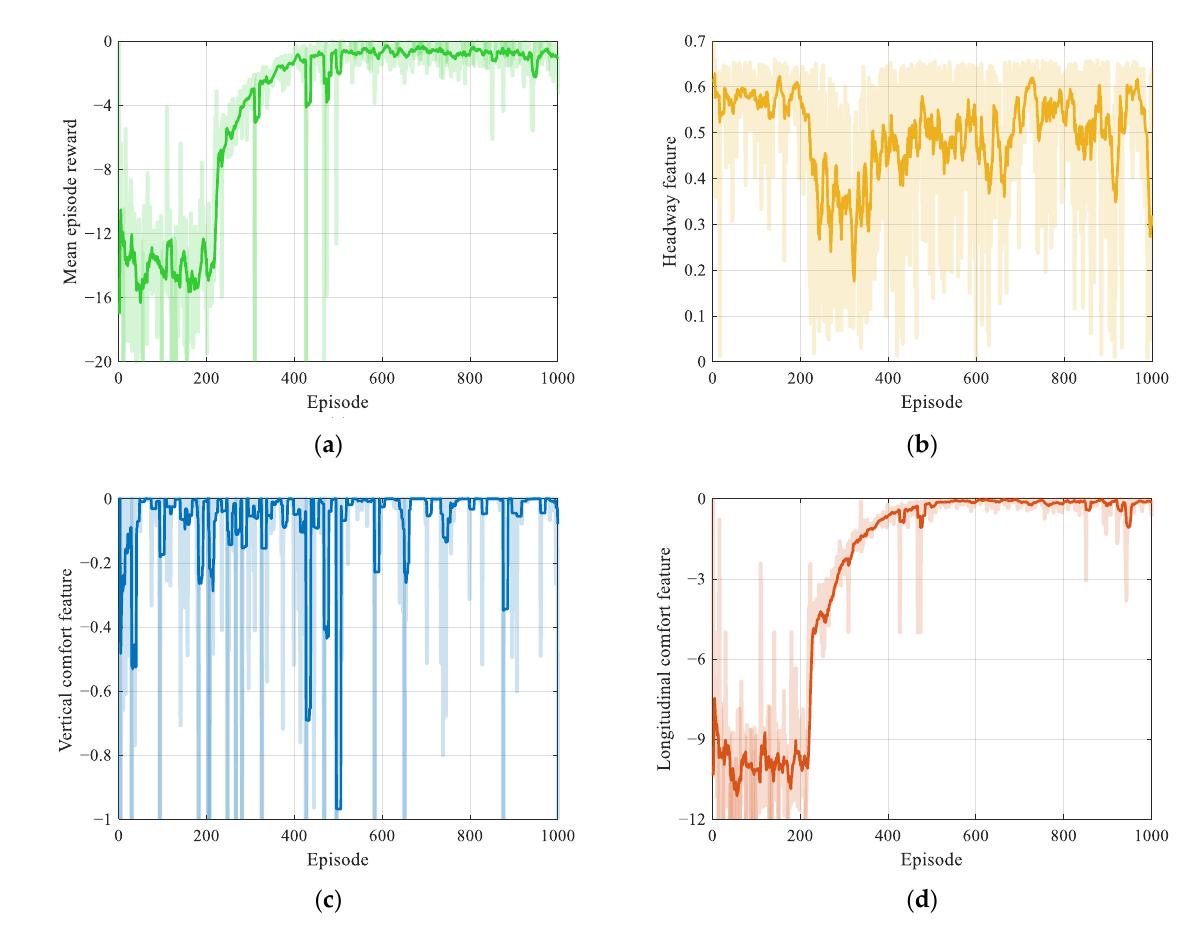
Figure 6. Training trajectories of the DDPG model: ( a ) mean episode reward, ( b ) headway feature, ( c ) vertical comfort feature, and ( d ) longitudinal comfort feature.